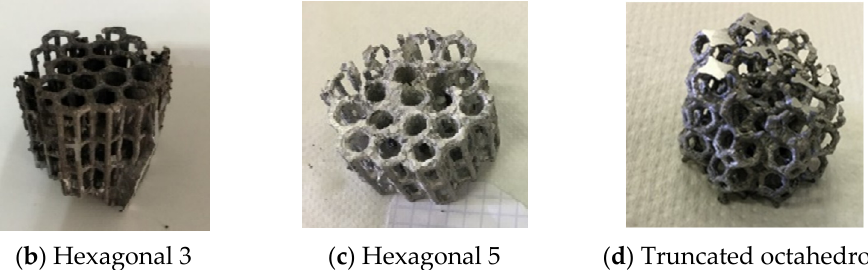
Figure 10. Al open cell manufactured foams: ( a ) icosahedral; ( b ) hexagonal; ( c ) hexagonal; ( d ) truncated octahedral. Table 1. Geometrical data and properties of manufactured